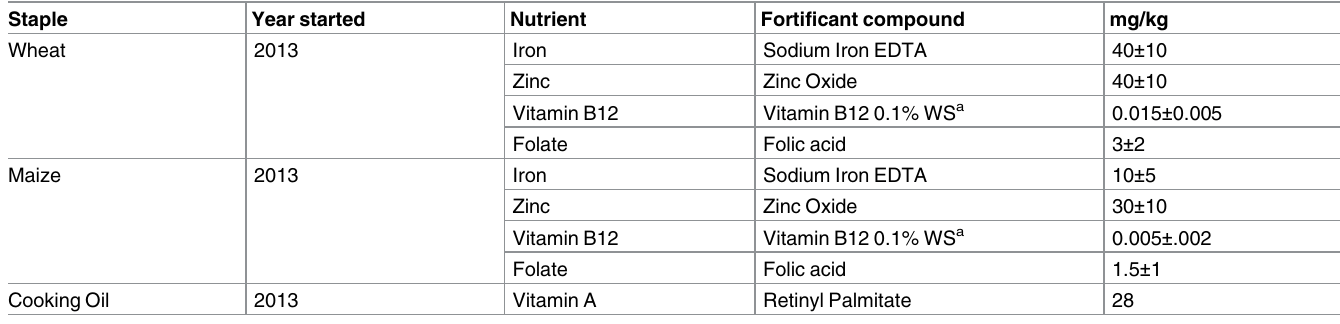
Table 1. Fortification of staple foods in